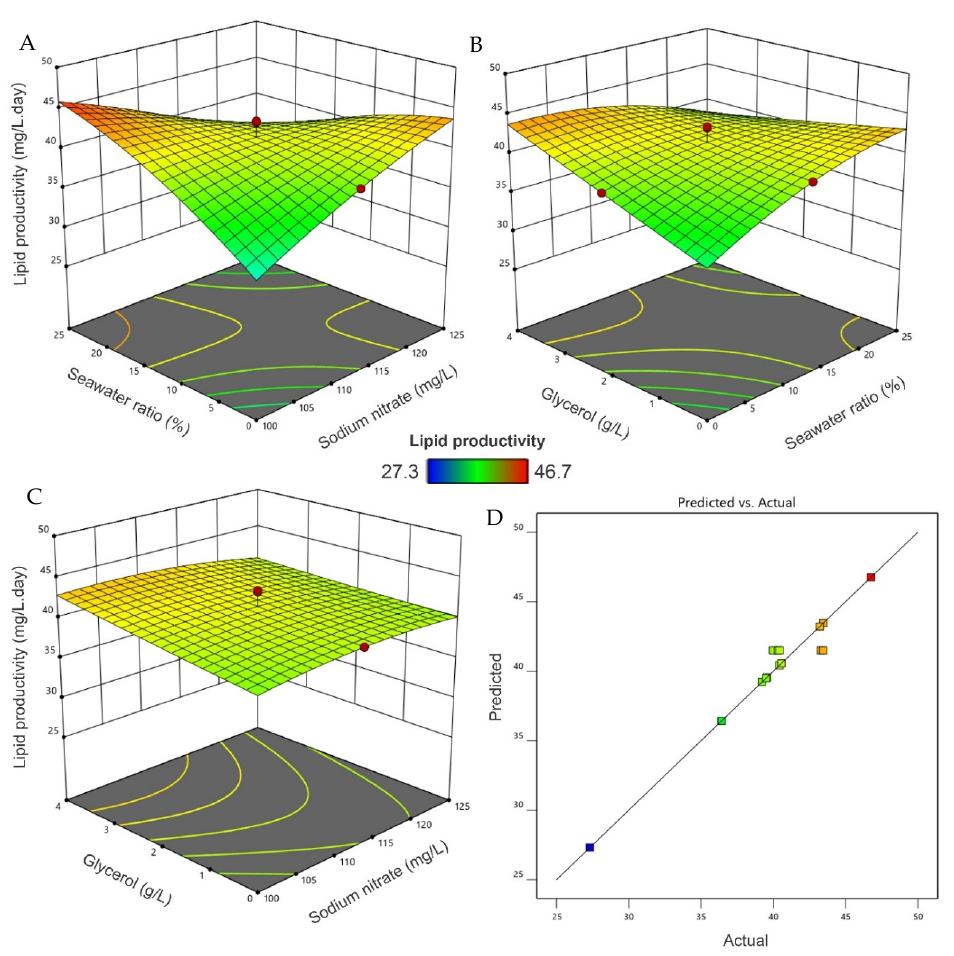
Figure 5. Central composite design showing the lipid productivity responses to different studied conditions of sodium nitrate, seawater, and glycerol (A–C) with the fitting graph of actual and predicted values (D).